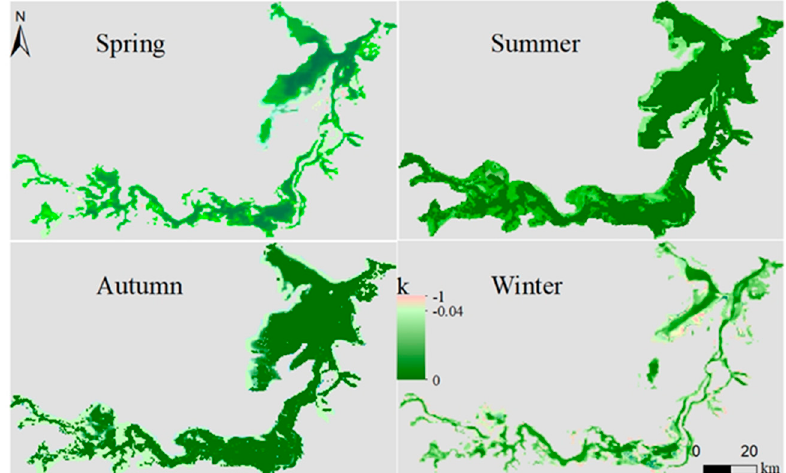
Figure 7. Spatial dynamics of interannual change trends in water surface area from the slope during 2001–2017 (k describes the rate of the frequency increasing / decreasing; a negative k indicates a decrease in the frequency (decreasing)).